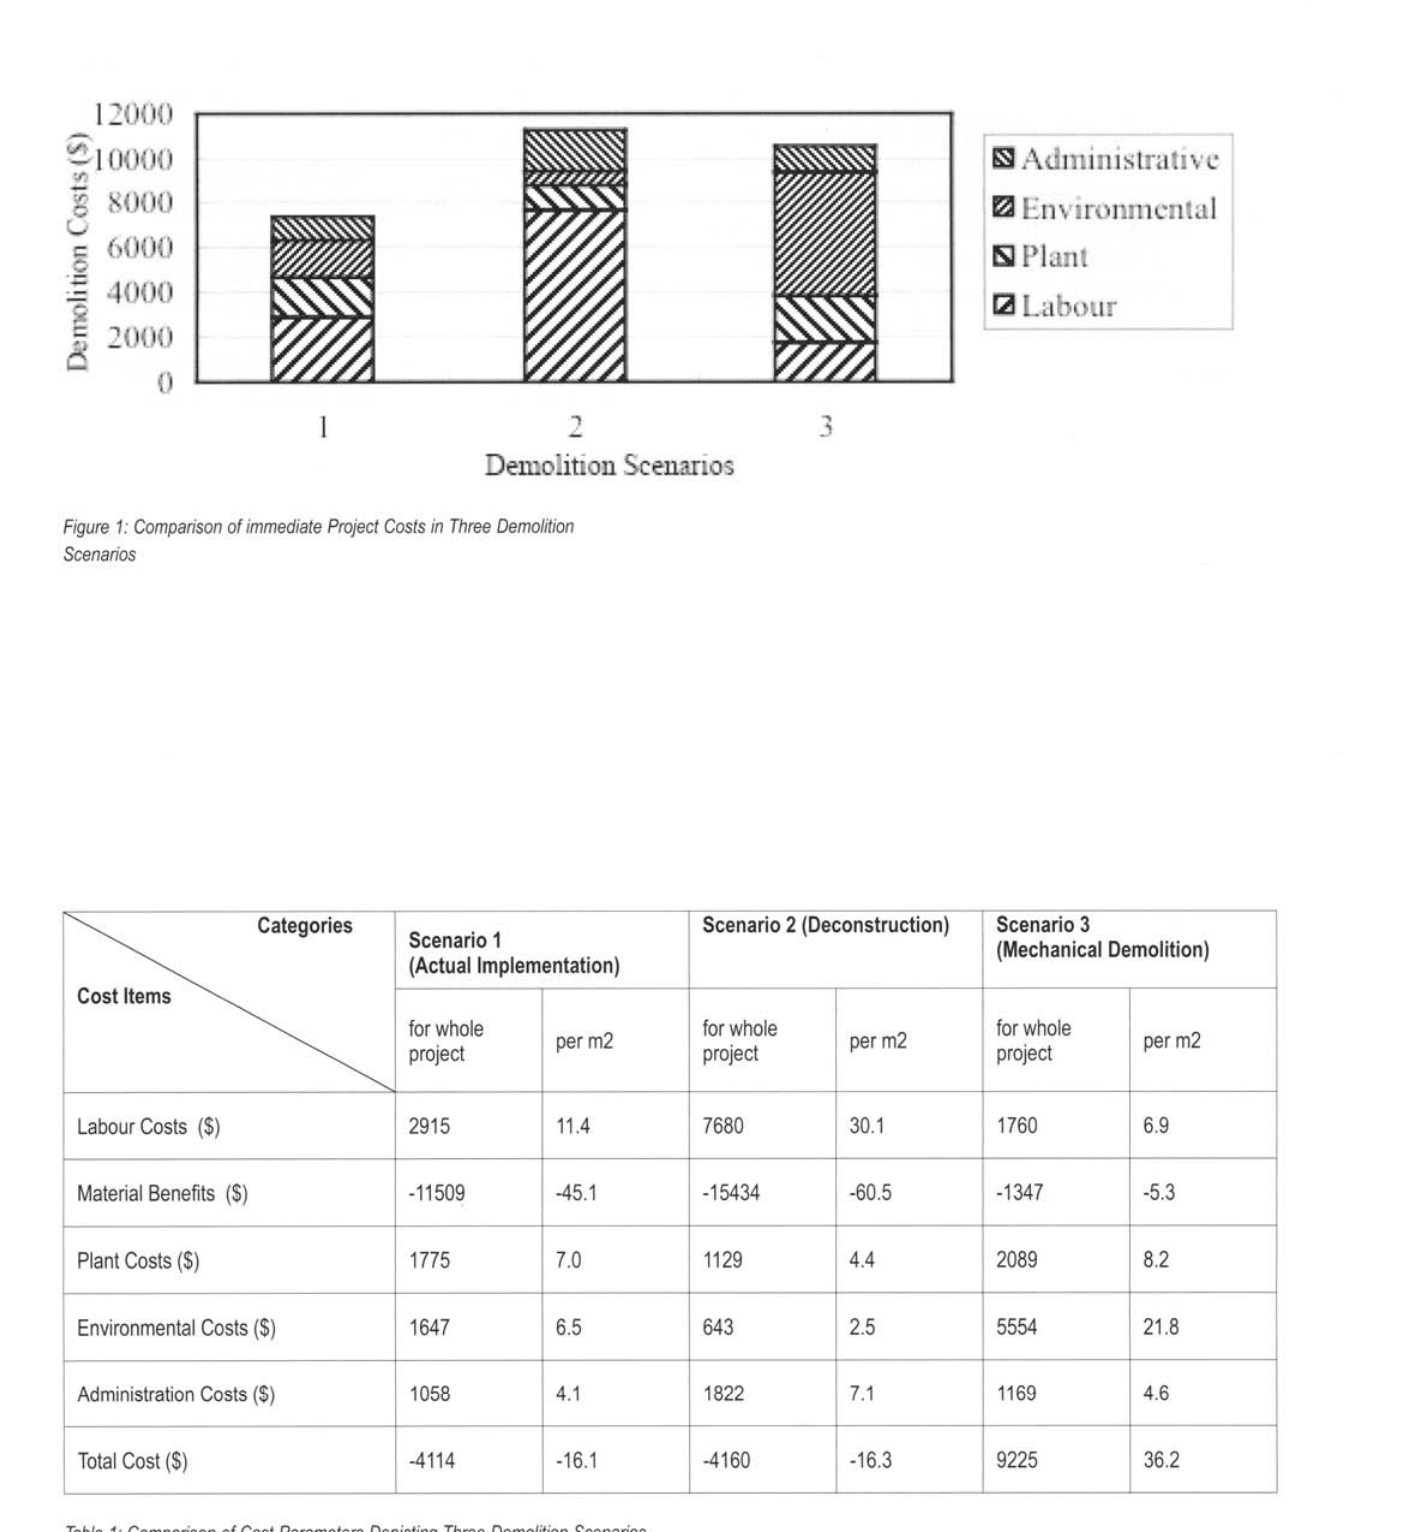
Table 1: Comparison of Cost Parameters Depicting Three Demolition